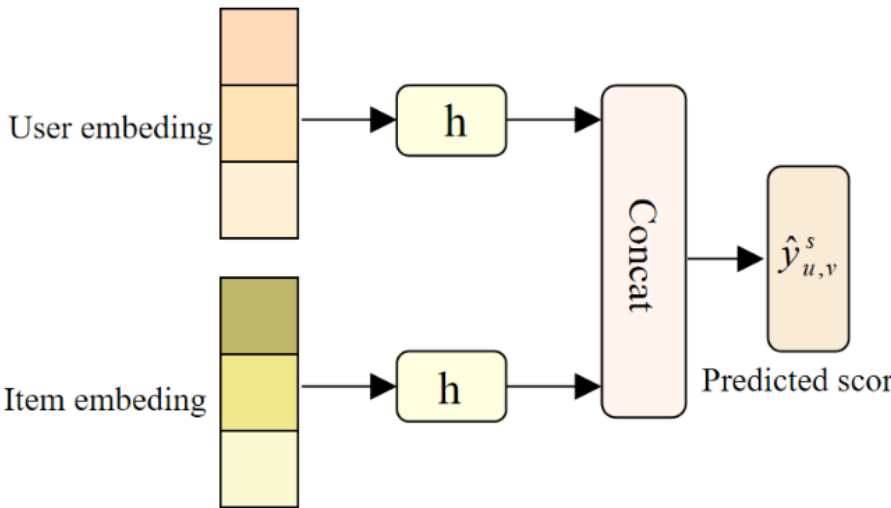
Figure 2. The process of generating predicted scores.